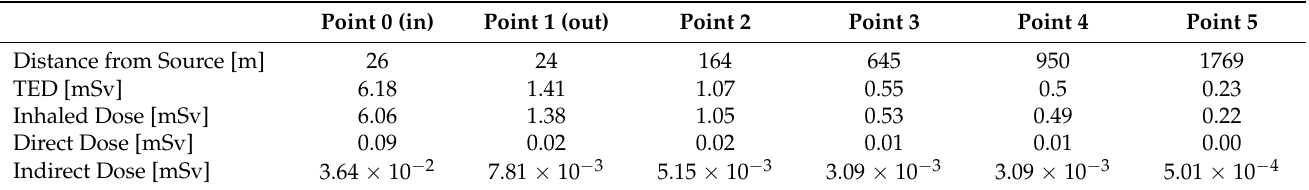
Table 3. Contributions to the total equivalent dose originating from the detonation of a 10 GBq Co-60 source.